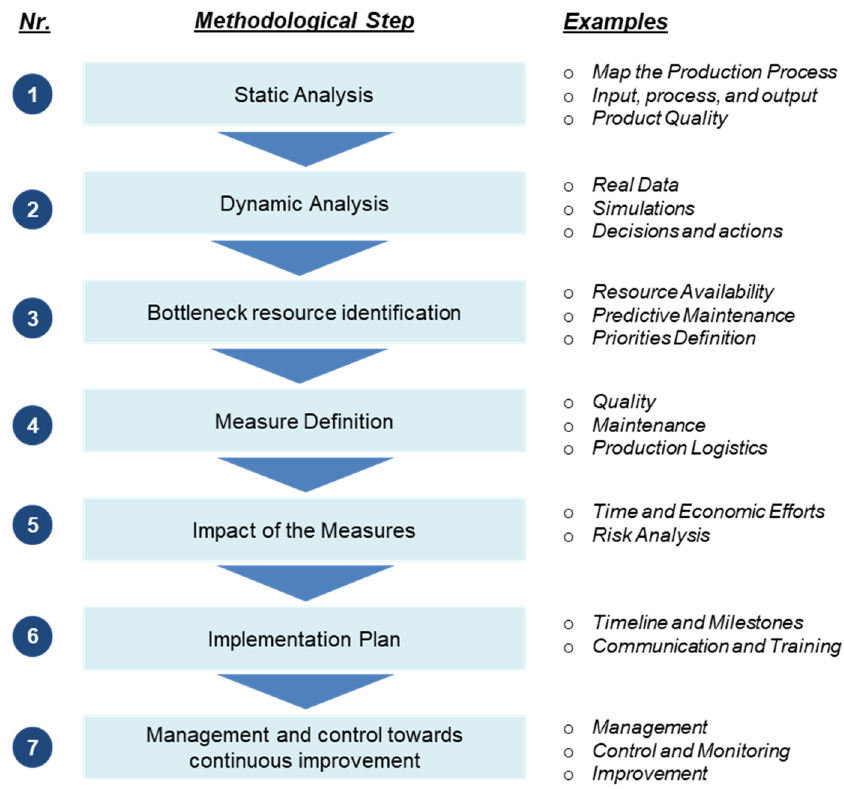
Figure 5. Methodology to assess and improve manufacturing systems (own Figure 5 . Methodology to assess and improve manufacturing systems (own elaboration).